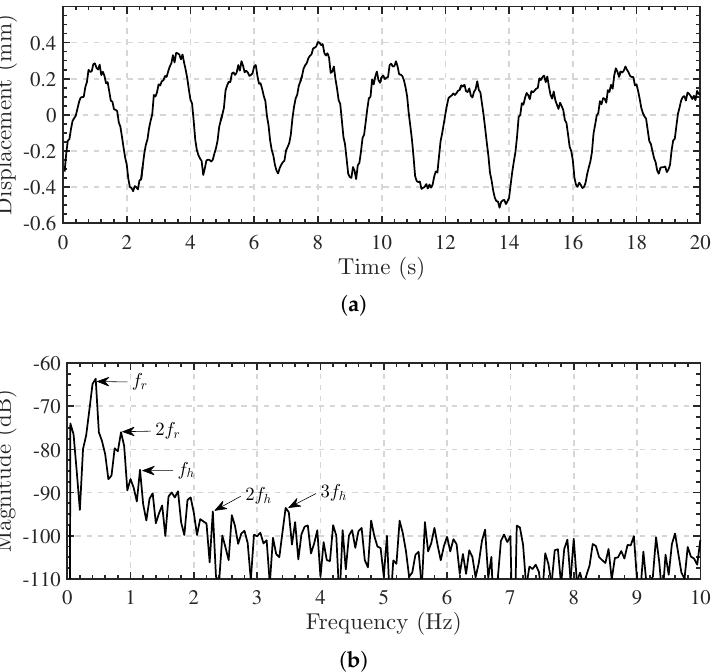
Figure 9. Vital signs signal (Subject 1) extracted by radar imaging. ( a ) vital signs signal in time domain. ( b ) Spectrum of the vital signs signal. The fundamental and harmonic frequencies of respiration and heartbeat are indicated.